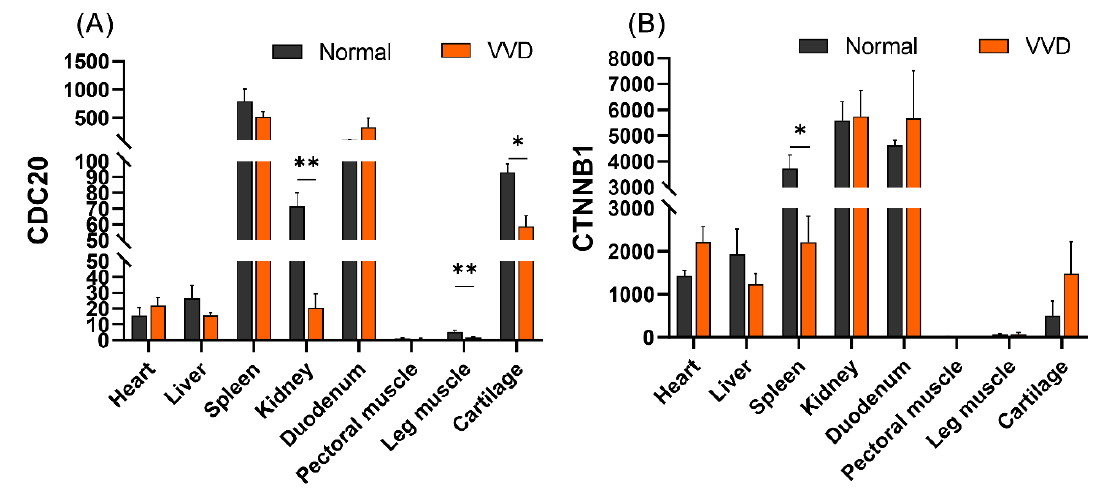
Figure 7. The expression profiles of CDC20 and CTNNB1 in VVD and normal broiler tissues: ( A ) tissue expression profiles of CDC20 in VVD and normal broilers; ( B ) tissue expression profiles of CTNNB1 in VVD and normal broilers. Data were expressed as mean ± SEM. ** P < 0.01, * P < 0.05.